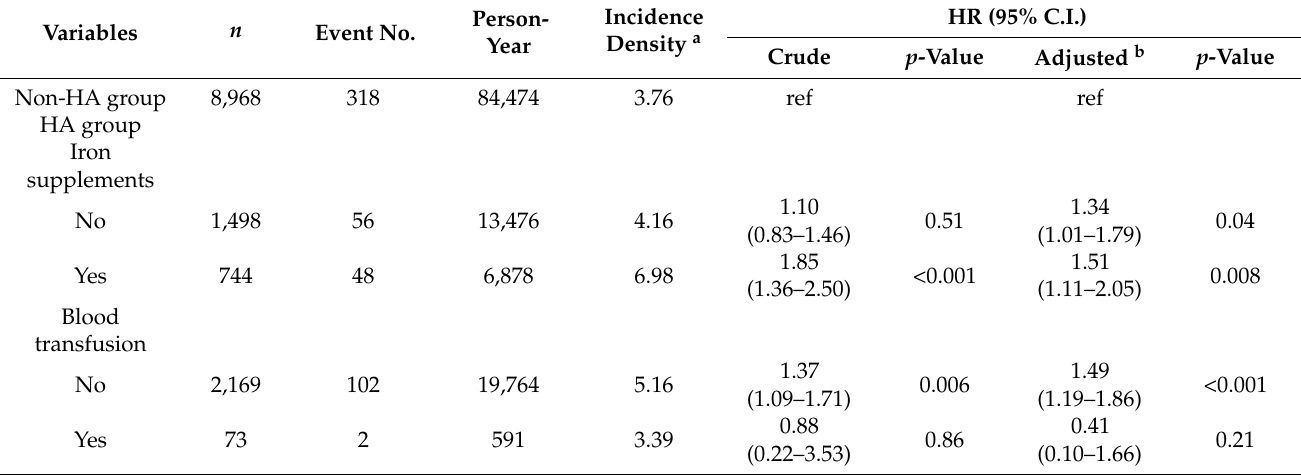
Table 4. Incidence density and hazard ratios of osteoporosis for hemolytic anemia status combined with therapy.